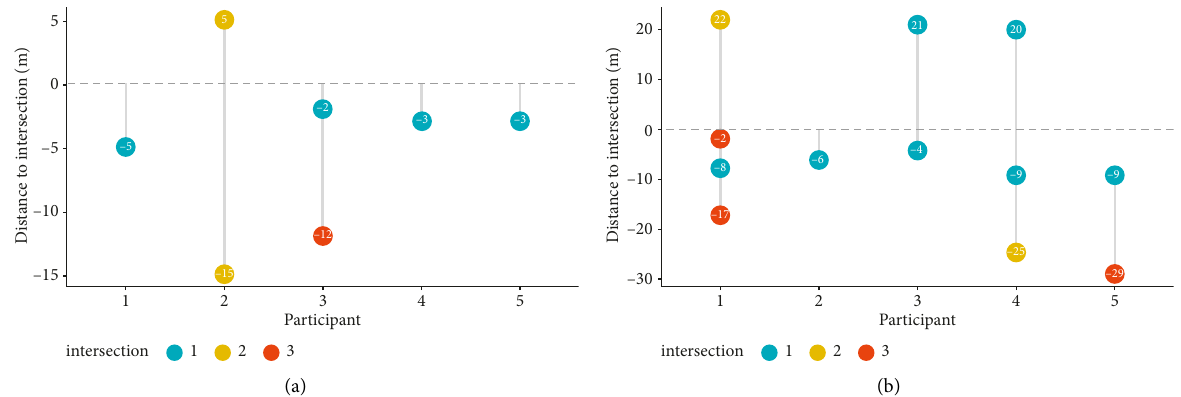
Figure 6: Summary of where the HR (a) and gaze transition entropy (b) change point happen for bicycle experiment. Each dot indicates an HR/GTE change point. The x -axis indicates the participant number, and the y -axis value is the distance to the intersection, where a negative value indicates the distance the change point happens before the participant arrives at the intersection. For example, participant 2 has two HR change points at 15meters prior to intersection 2 as well as 5meters after passing through that intersection (a). And, participant 2 has one GTE change point 6meters prior to intersection 1.